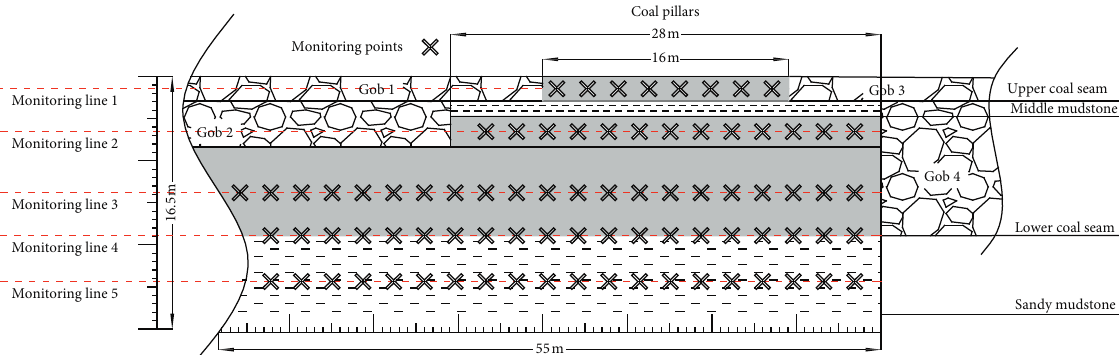
Figure 15: Monitoring curve of coal seam and floor